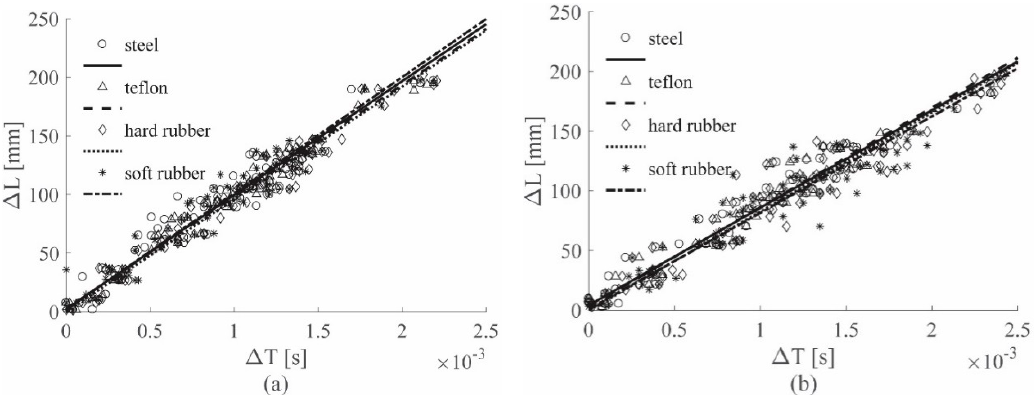
Figure 14. ( Δ L – Δ T ) automatic approach results for the Al plate, all tips, the ACC sensors ( a ) and the PZT sensors ( b ), both filtered with the 0–619 Hz filter.